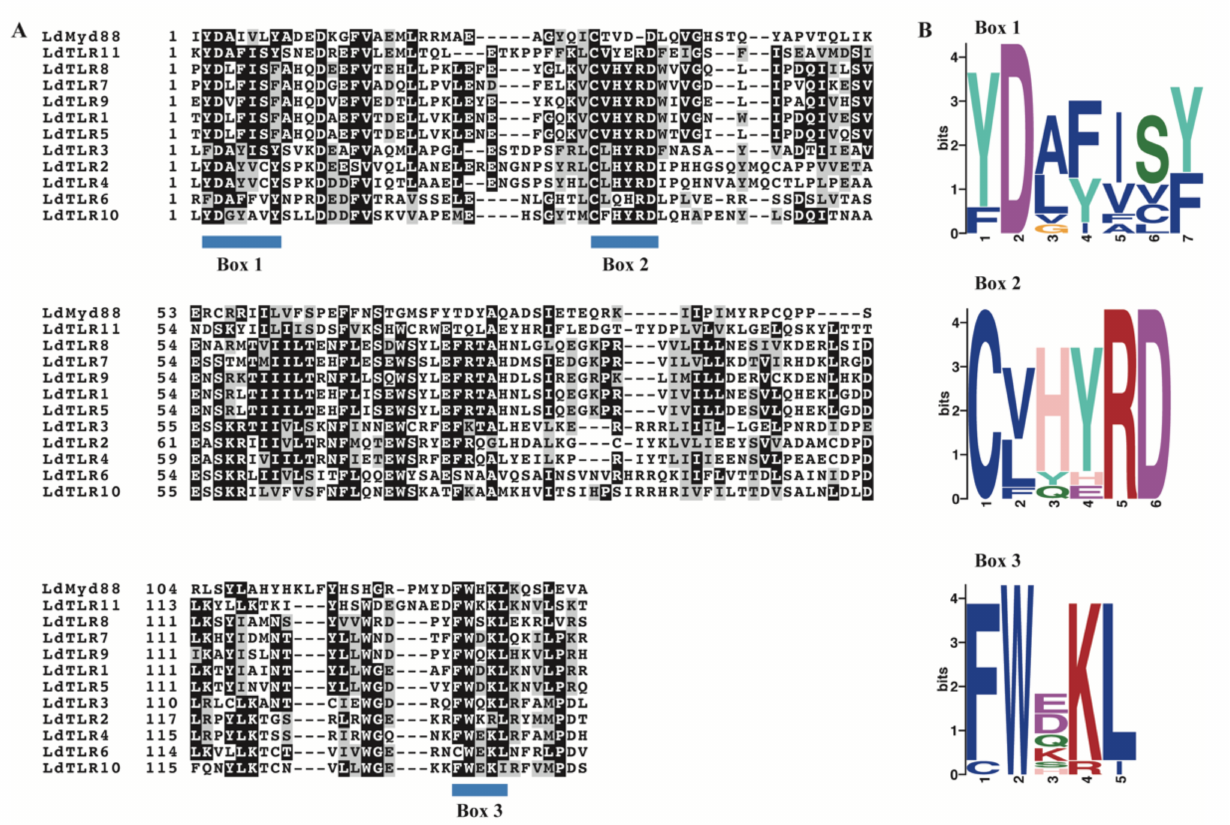
Figure 2. ( A ) Sequence alignment of TIR domains in 11 LdTLRs and LdMyD88. Blue bars indicate conserved motifs of TIR domains. ( B ) Sequence logos of Box 1–3 in the TIR domains of 11 LdTLRs and LdMyD88. Numbers on the horizontal axis represent the sequence positions in the motifs and the vertical axis represents the information content measured in